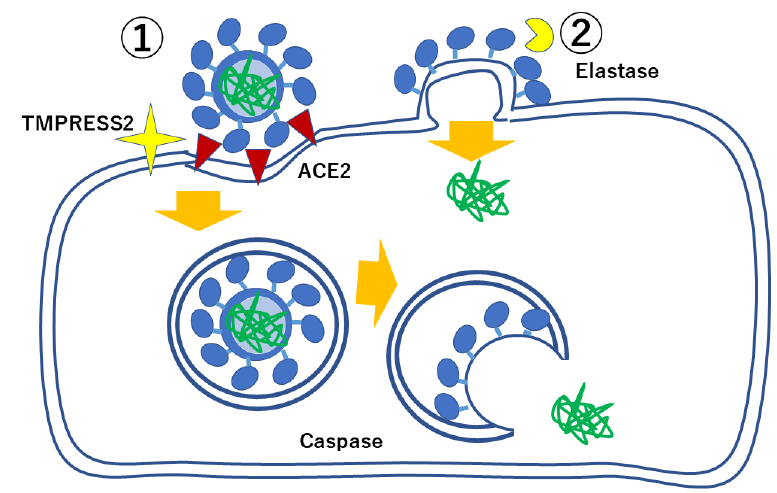
Figure 2. The infection pathway of SARS-CoV-2 differs depending on the inflammation status. Without inflammation, SARS-CoV-2 utilizes TMPRSS2 to enter cells with the ACE2 receptor through endocytosis, while with inflammation, SARS-CoV-2 utilizes environmental elastases to enter cells through membrane fusion, with rapid replication of themselves. Modified from reference [13].